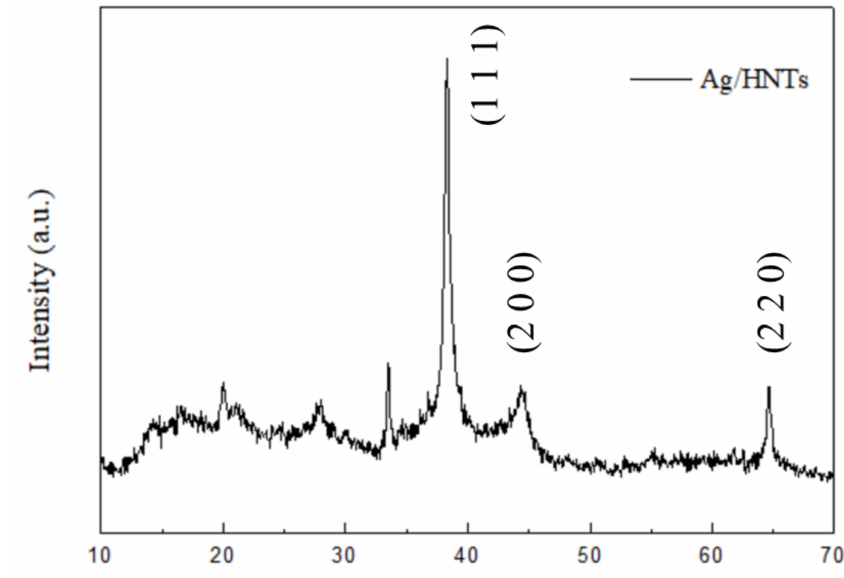
Figure 2. X-ray di ff raction (XRD) patterns of the Ag /